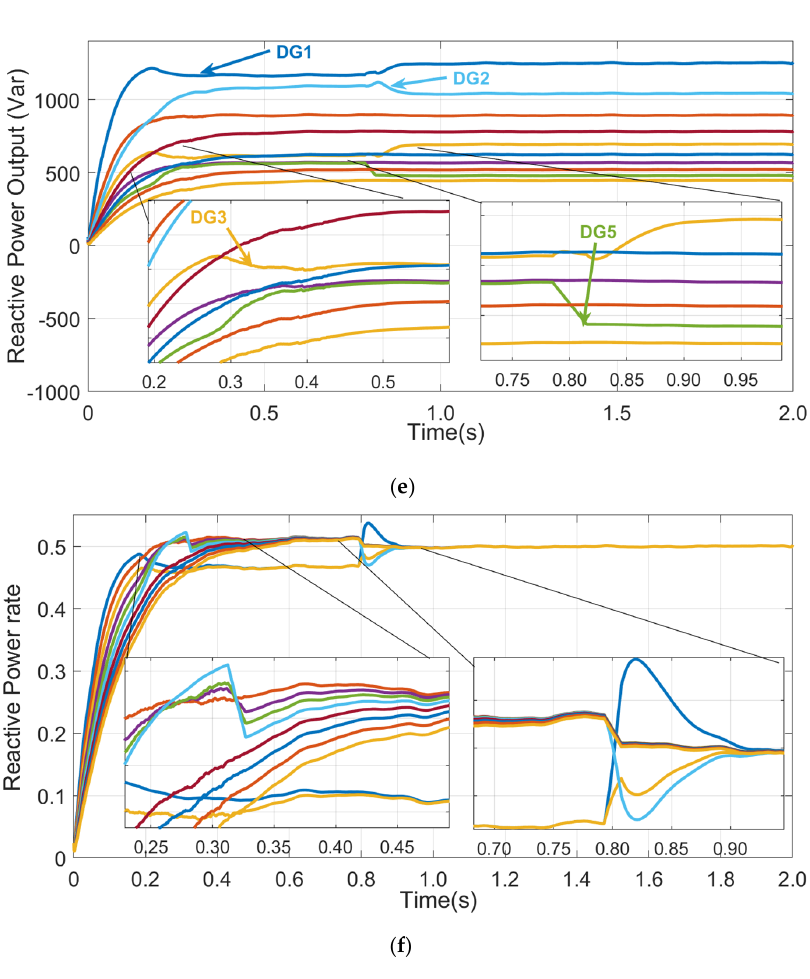
Figure 15. Simulation results for reactive power output with three types of communication failure: ( a )–( b ) for type (a) failure; ( c )–( d ) for type (b) failure; ( e )–( f ) for type (c) failure.